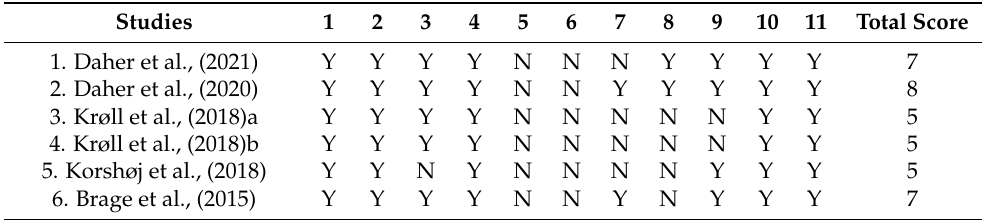
Table 2. Methodological quality assessment using the PEDro scale